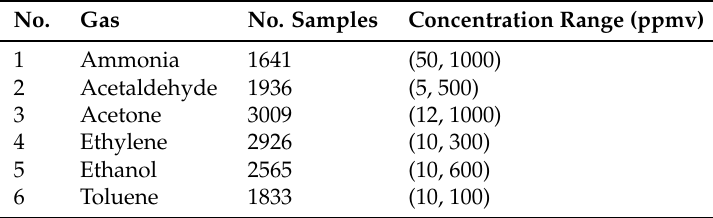
Table 1. The details of dataset1.